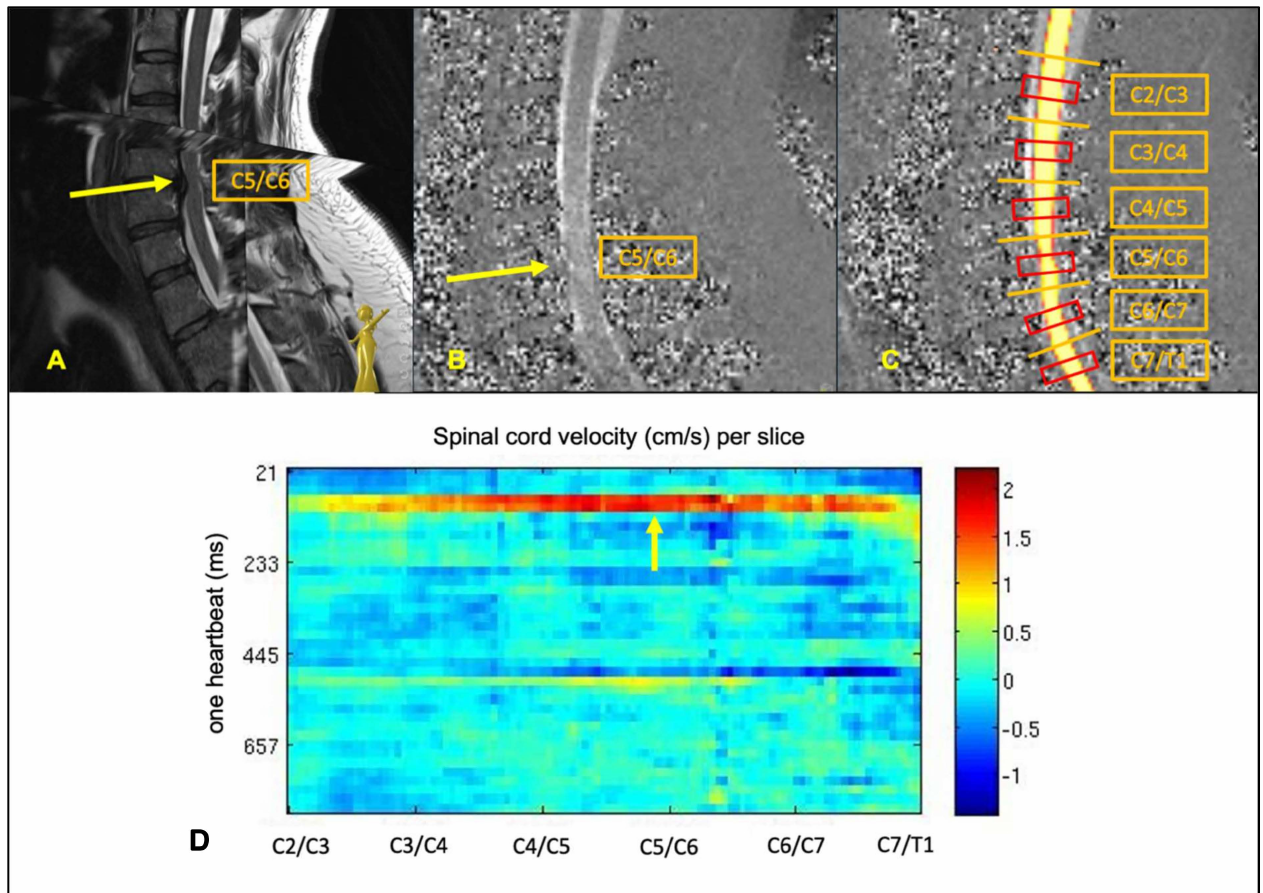
Figure 1. Example of spinal cord motion assessments within the current data processing pipeline. Top row ( A ): 3D T2w SPACE sagittal image of a patient with stenosis at C5/C6 (yellow arrow). ( B ): one exemplary phase-contrast image of the same patient within one heartbeat; the yellow arrow points onto the light grey colored spinal cord that reflects the focally increased craniocaudal spinal cord motion compared to the darker grey colored spinal cord motion at the surrounding segments. ( C ): segmentation of the phase-contrast image of the same patient, red squares demonstrate the ROIs per cervical segment covering 1/3 of the intervertebral space. ( D ): example of the spinal cord velocity plot of the same patient demonstrating color-coded spinal cord velocities (cm/s) (right side) per slice ( x -axis) and per assessed time point ( y -axis) during one heartbeat